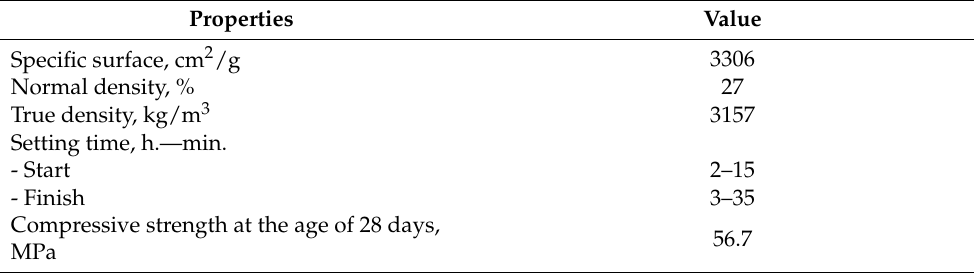
Table 3. Characteristics of